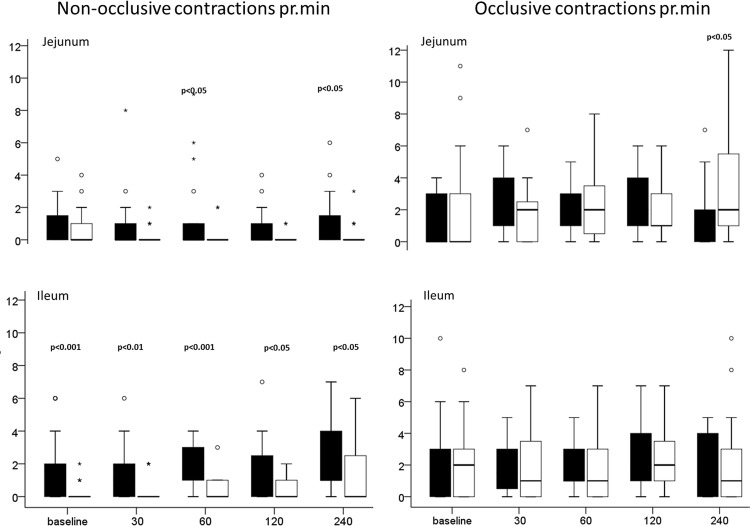
Contractions in small bowel obtained by Ultrasound.Box plots showing the number of non-occlusive ileal and jejunal contractions and the number of occlusive ileal and jejunal contractions pr min obtained by ultrasound for each of the study time points. The median is shown within the box; the box represents the 25 and 75 percentiles and the whiskers 10 and 90 percentiles. The black boxes display FGDS patients, the white boxes the Healthy controls.